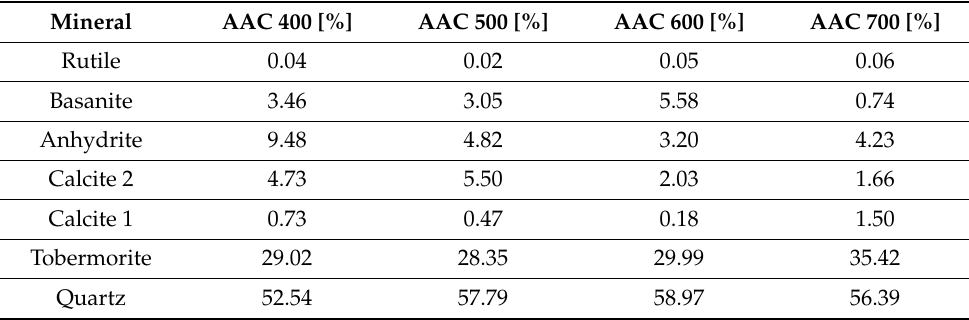
Table 1. Percent phase